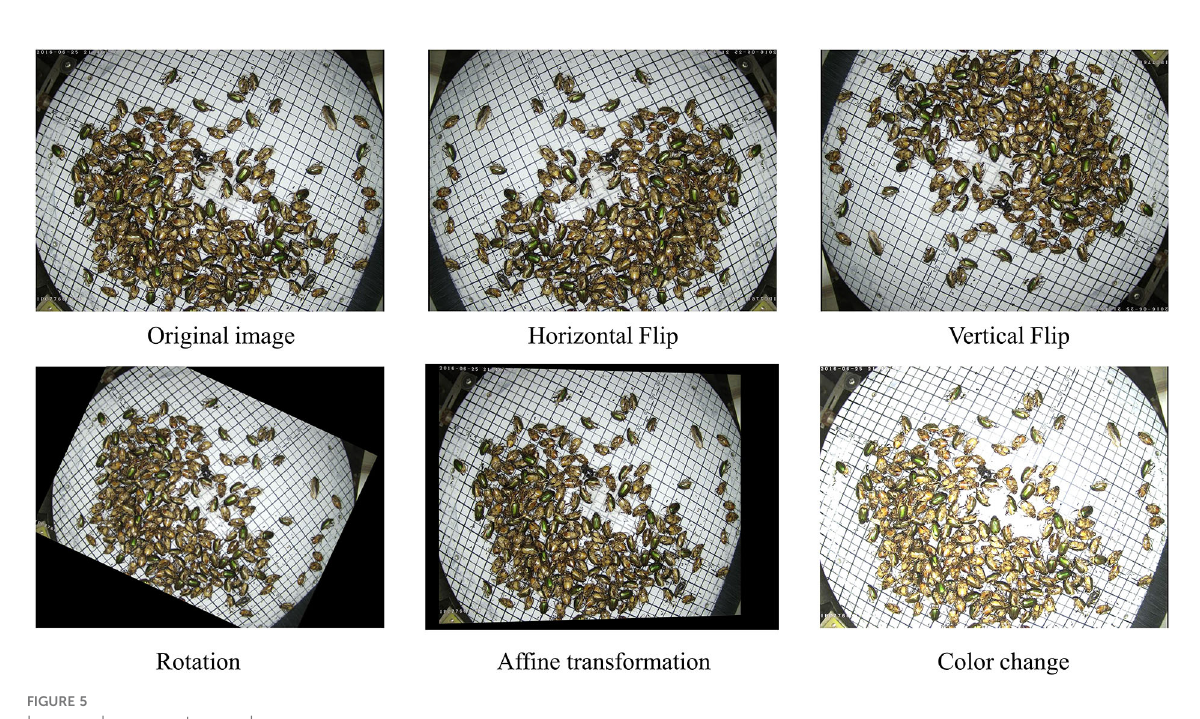
FIGURE 5 Image enhancement